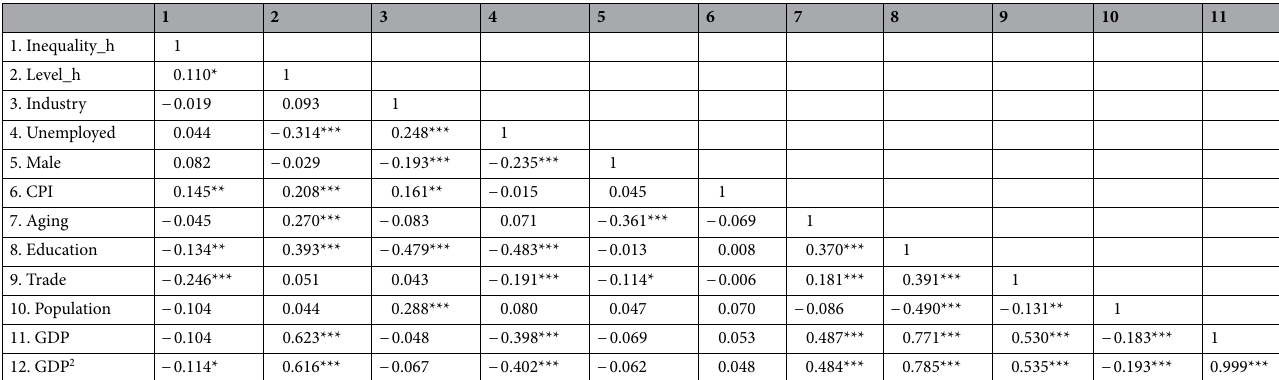
Table 3. Bivariate correlation results. ***p < 0.01, **p < 0.05, and *p < 0.1.